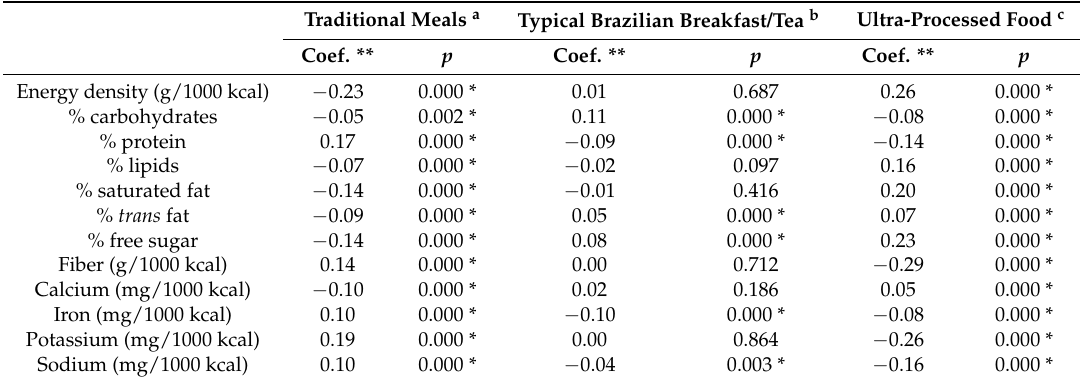
Table 3. Association between dietary markers and fifths participation in each pattern scores adjusted for personal, sociodemographic and socioeconomic characteristics and the percentage of calories consumed outside of the home. Brazilian population aged 10 and up